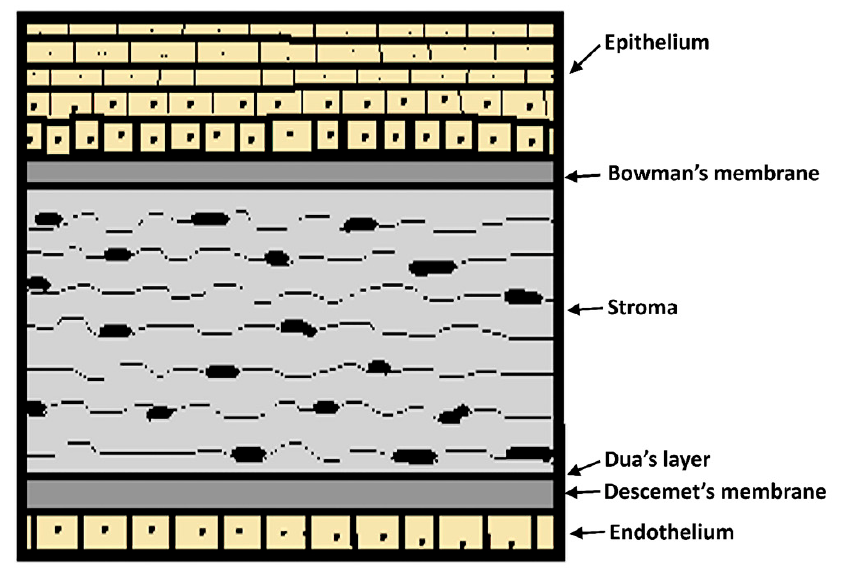
Figure 5. Schematic representation of the human corneal layers.